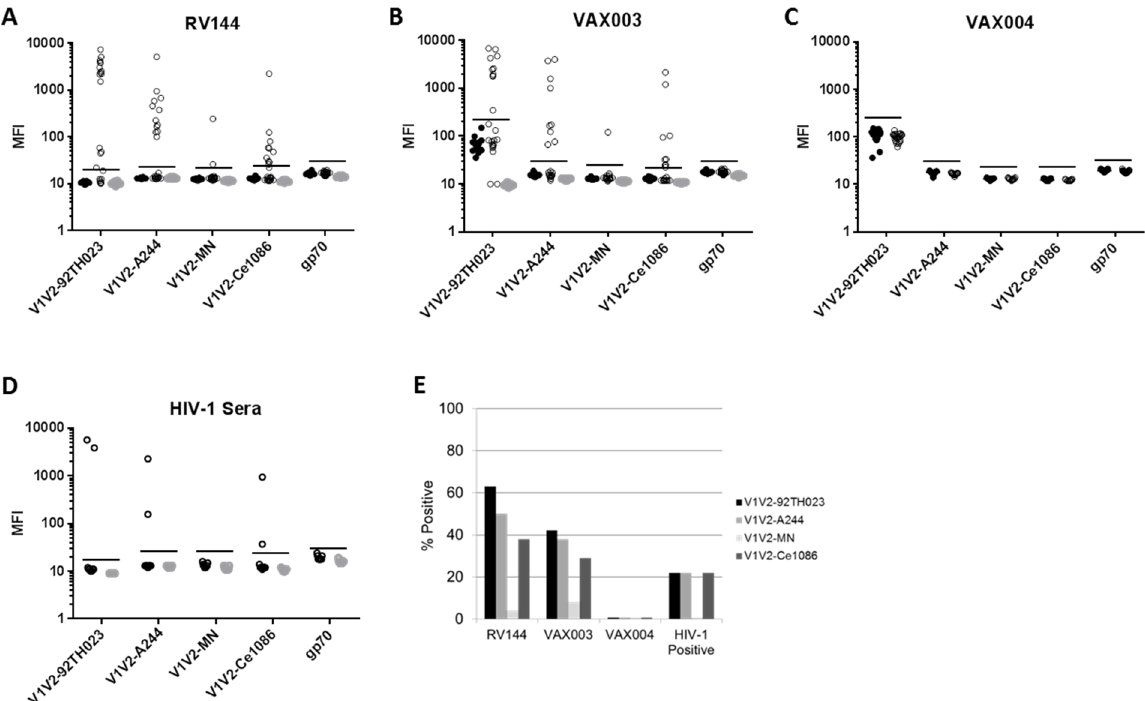
Fig 2. V1V2-specific complement activating antibodies in vaccine recipients and HIV-1-infected individuals. Samples obtained post-immunization or post-infection were assayed with gp70 and gp70-V1V2 scaffolds in the presenceof either NHS as a source of complement(black open circles) or C3-deficient human serum (gray circles). Pre-immunizationsamples from vaccine recipients were assayed in the presence of normal humanserum (black solid circles). Magnitude of complementactivation is expressedas mean fluorescence intensity (MFI) of C3d detectionfor RV144 ( A ), VAX003 ( B ), VAX004 ( C ) and HIV-1-infected individuals ( D ). Note that post-immunizationsamples in VAX004 were not assayed in the presenceof C3-deficient humanserum. E. Percent of positive reactions in RV144, VAX003, VAX004 (n = 24 each) and CRF01_AEHIV-1-infected individuals (n = 9). Values > 2x the highestnegativecontrol value were considered positive (valuesabovethe horizontallines). Pre-immune sera from vaccine recipients assayed in the presenceof NHS served as negativecontrols for RV144, VAX003 and VAX004. Assays in the presenceof C3-deficient humanserum served as negative controls for HIV-1-infected